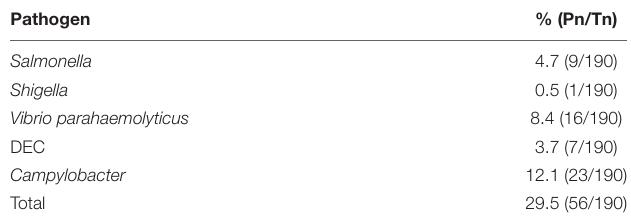
TABLE 2 | Pathogen culture results of the 190 stool samples.